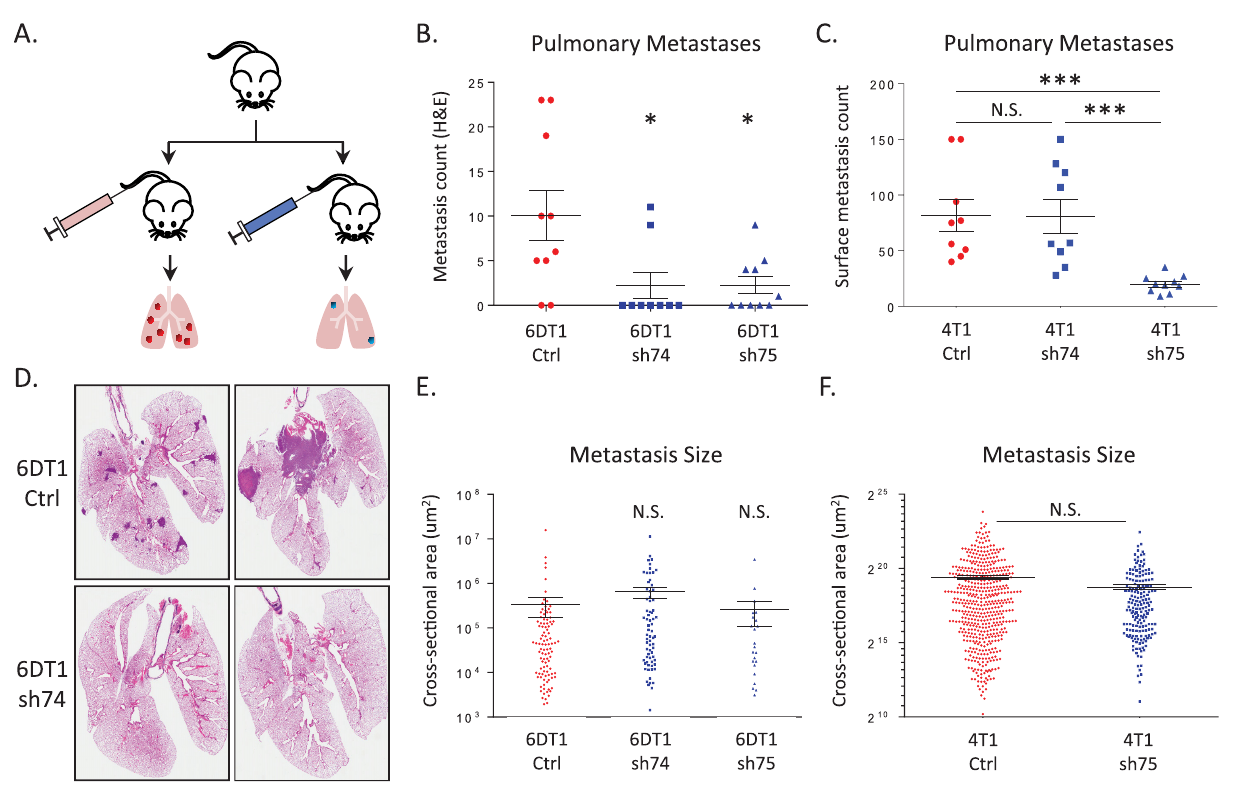
Fig 4. (A) Schematic of the experimental metastasis assay. Surface pulmonary metastases counts for 6DT1 are displayed in (B) and in (C) for 4T1. D) Representative H&E stained lung sections are shown for the 6DT1 experiment. Relative metastasis size is indicated in panel (E) for 6DT1 and (F) for 4T1. N. S. = not significantly different. * = p < 0.05; *** = p <